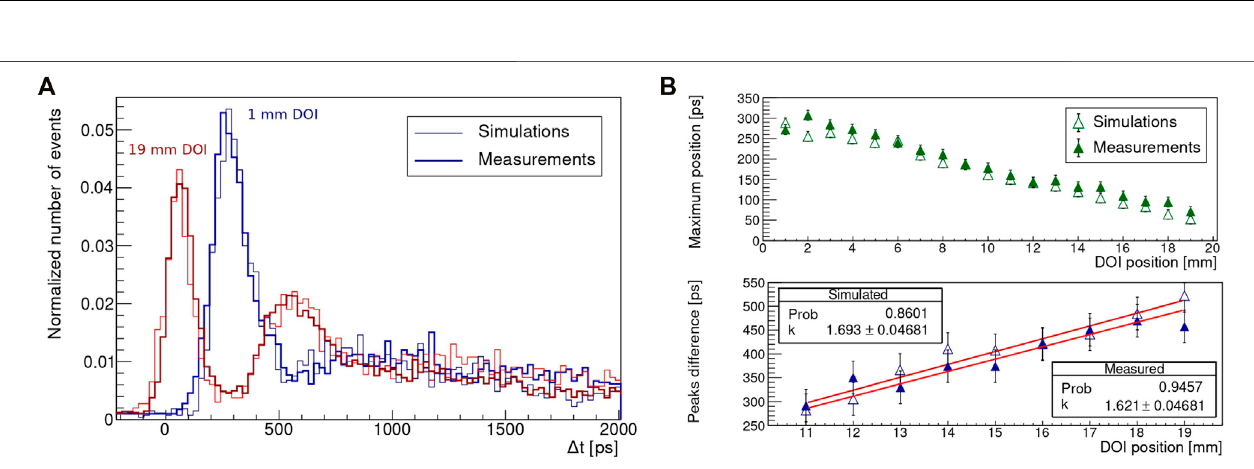
FIGURE6|(A) Comparisonbetweenthemeasuredandsimulatednormalizedtimedistributionsattheextremesofthecrystal,DOI=1 mm(blue)and19 mm(red). (B) PositionofthemaximumanddistancebetweenthetwopeaksofthemeasuredandsimulatedtimedistributionsasafunctionofDOI. Eq.(4) isusedtoextractthecoef fi cient k .